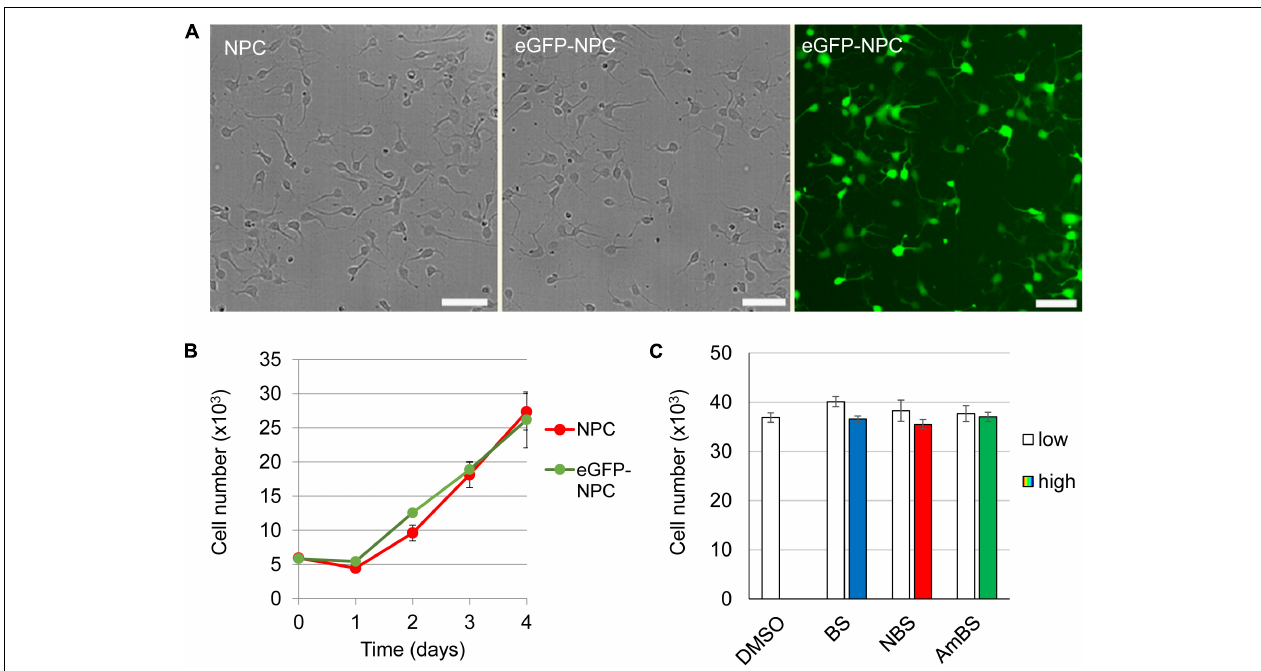
FIGURE 1 | Characterization of human neural progenitor cells stably expressing eGFP. eGFF was stably expressed in human NPCs using a Sleeping Beauty transposon-based expression system. (A) No morphological difference between the parental (NPC) and the GFP-expressing NPCs (eGFP-NPC) can be observed. However, the transfectants exhibit uniform green fluorescence, making not only the cell body but also the neurites visible. (B) There is no difference in the proliferation capacity of NPCs and eGFP-NPCs. (C) The cytotoxic effects of blebbistatin (BS), para-nitroblebbistatin (NBS), and para-aminoblebbistatin (AmBS) was investigated by subjecting eGFP-NPCs (3 × 10 4 ) to these compounds 2 h after seeding. BS and NBS were applied at 10 or 20 µ M concentrations marked as low and high, respectively; whereas AmBS was used at 20 or 40 µ M concentrations. The cell numbers were determined 4 h after the treatments and compared to the cell number of the vehicle (DMSO) treated sample. The mean ± SEM values from three independent experiments are shown in (B,C) . No significant differences were